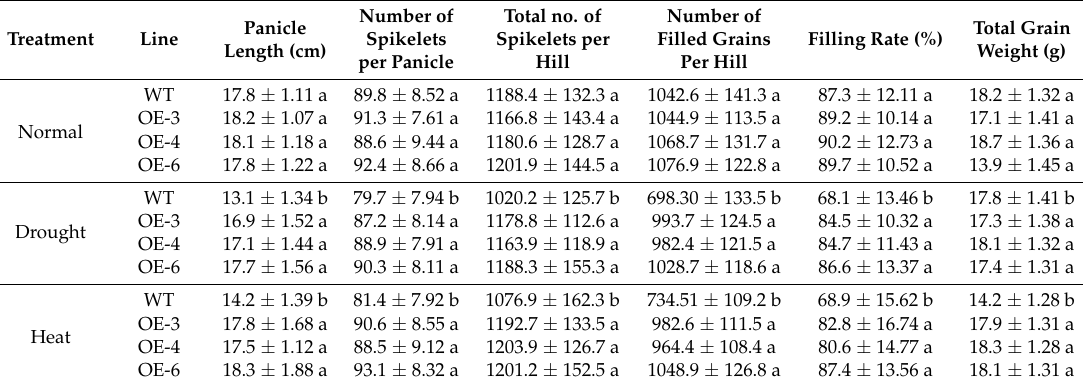
Table 2. Yield traits of WT and transgenic rice lines under normal and stress